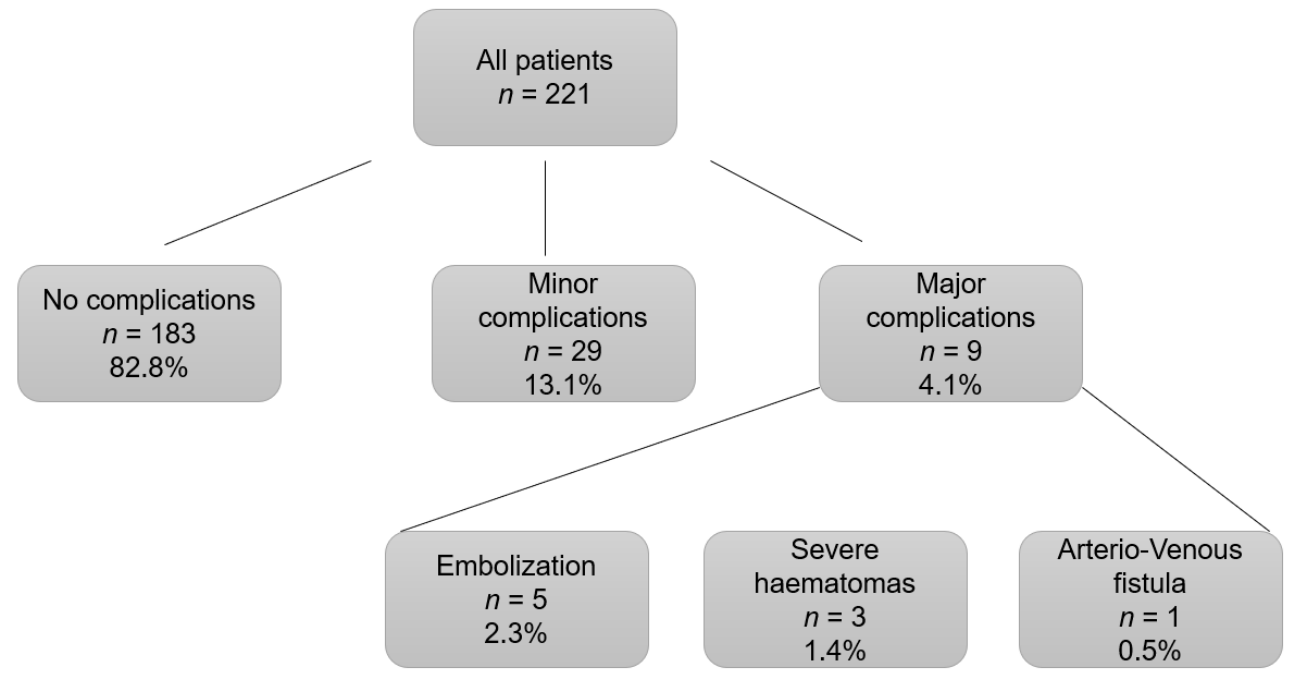
Figure 2. Complications post-kidney biopsy. Distribution by percentages according to presenting complications after kidney biopsy.